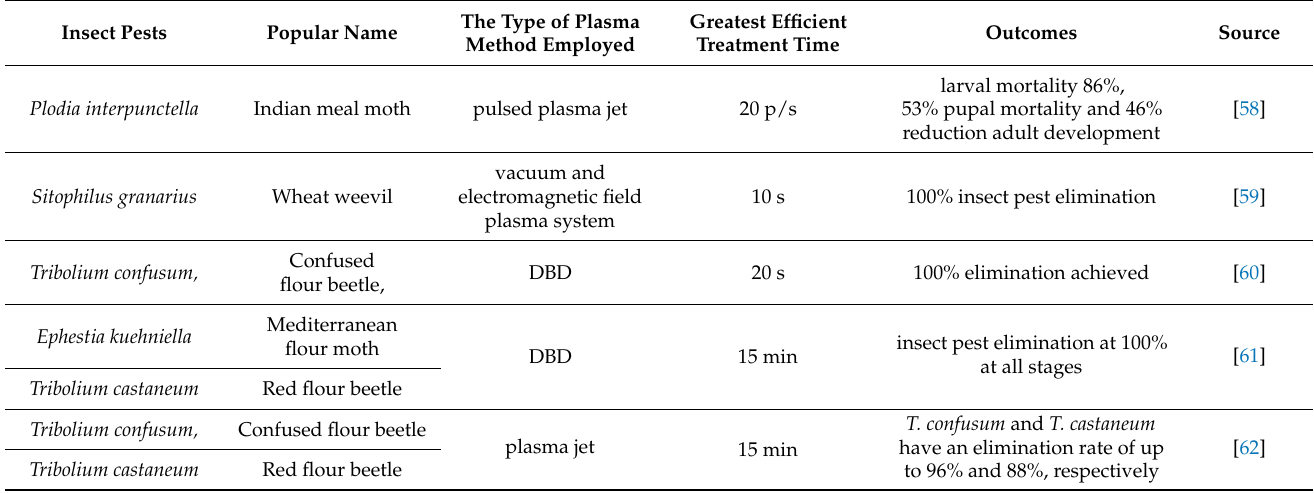
Table 2. Cold plasma experiments illustrating treatments of insect